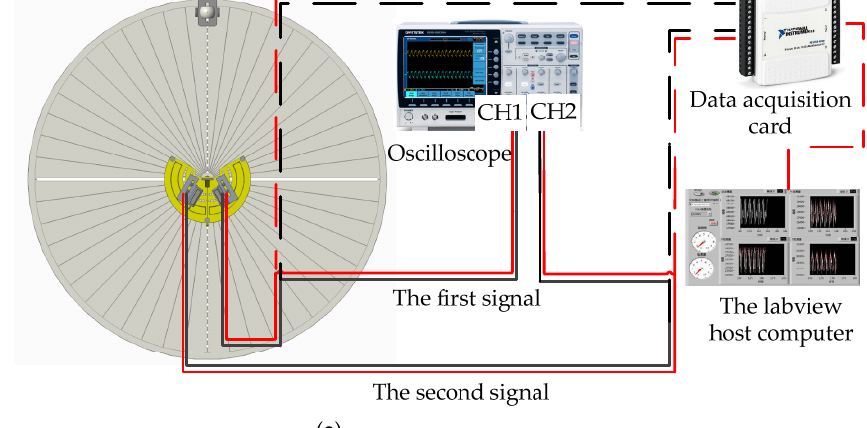
Figure 14. Characteristics of key equipment. ( a ) Characteristics of the sound source equipment. ( b ) Characteristics of the laser.